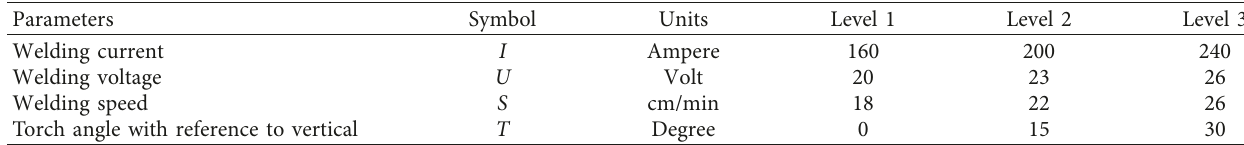
Table 2: Process parameters and design levels used in experiments.